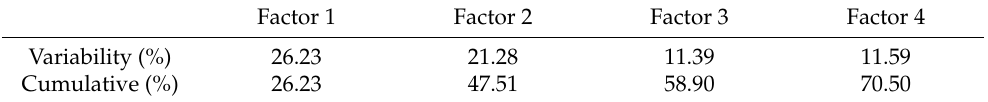
Table 6. Percentage of variance and cumulative variance after varimax rotation (high–high). Factor 1